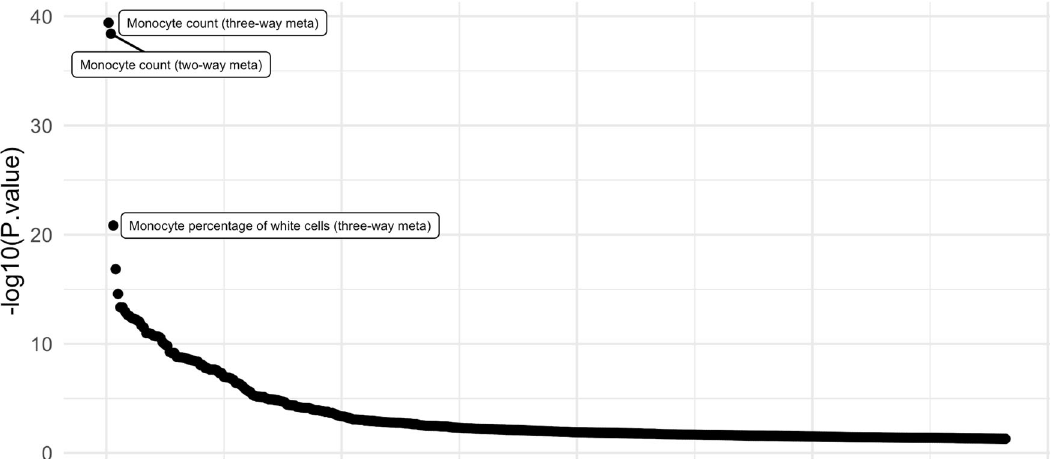
Fig. 3 Regional phenome-wide association study (pheWAS) of FLT3 for 2977 unique traits. Each point represents a trait. Only traits with an association ( P < 0.05) were included for the